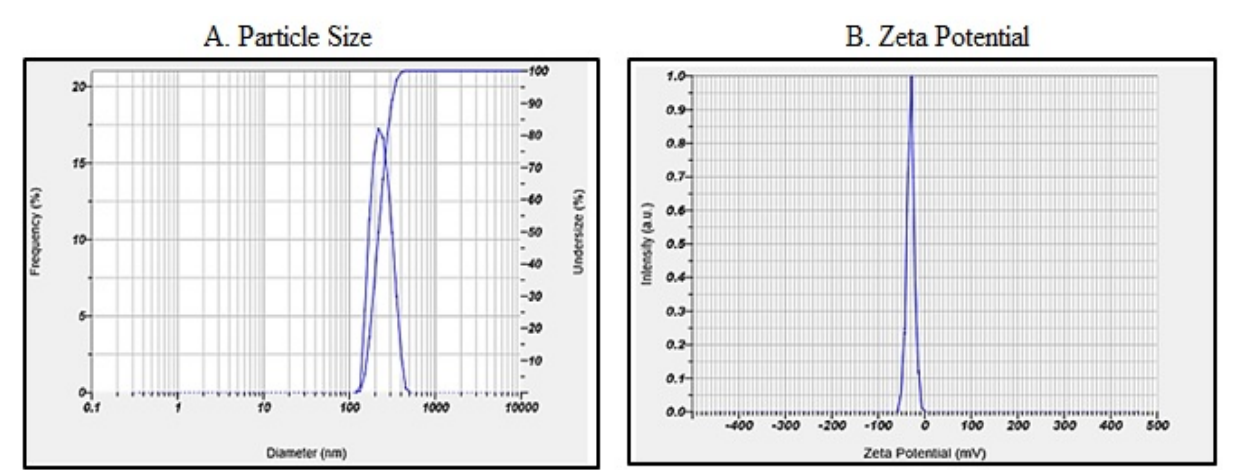
Figure 4. Particle size distribution curve ( A ) and zeta potential peak ( B ) of the optimized formula- tion NS9.